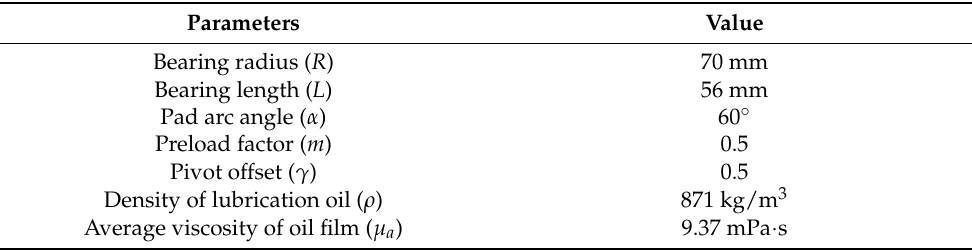
Table 2. Parameters of tilting pad bearing.